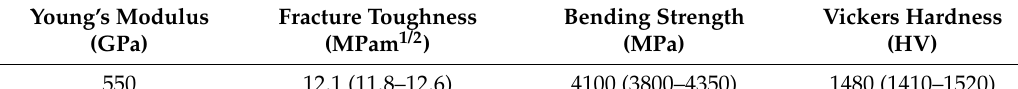
Table 2. Mechanical properties of the WC-Co cemented carbide.